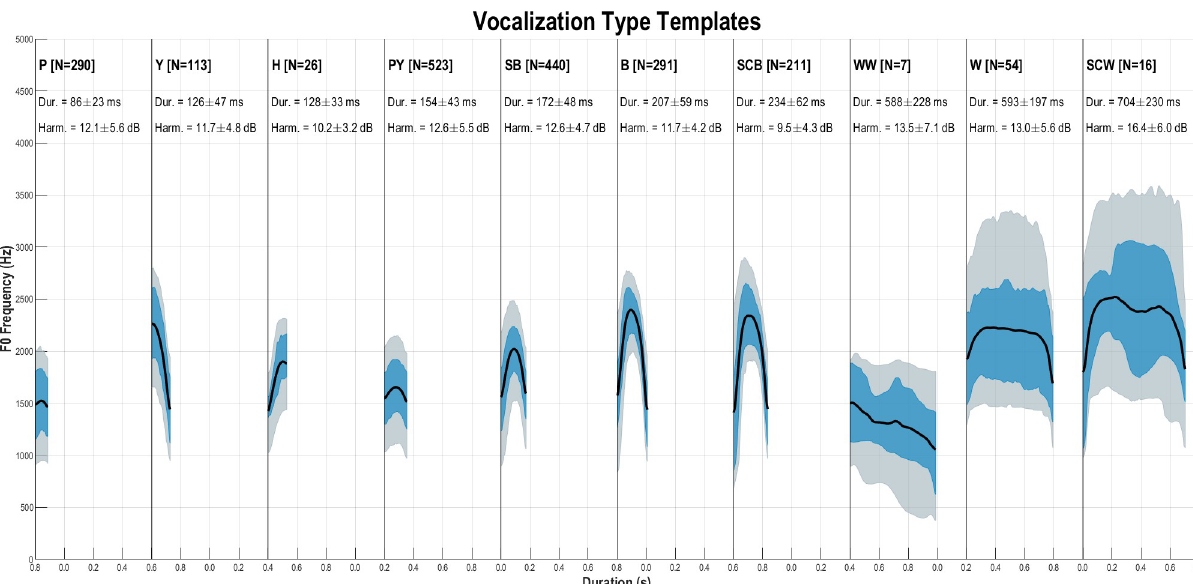
Fig 3. Templates of f 0 (pitch) for each call type. The average f 0 trajectory (black line) is calculated from all recordings (using Praat). The shaded area covers 50% or 80% of the distribution (blue and grey areas respectively). For each type of call, individual calls were time-scaled to the average duration of the type. N = number of calls analyzed; Dur = call duration (mean and standard deviation, in ms); Harm = harmonicity (mean and standard deviation, in dB). The types are ranked by increasing average duration: Peep (P), Yelp (Y), Hiccup (H), Peep Yelp (PY), Soft Bark (SB), Bark (B), Scream Bark (SCB), Whining Whistle (WW), Whistle (W), and Scream Whistle